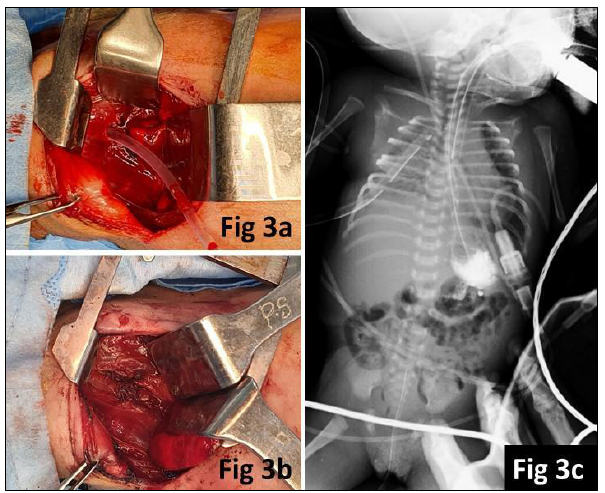
Fig.3a. Complex tracheo-esophageal trauma with the NG tube seen lying in the pleural cavity through the rent in the upper pouch, Fig.3b. Repair of the tracheo-esophageal trauma and the primary repair and Fig.3c. No leak in the post-operative